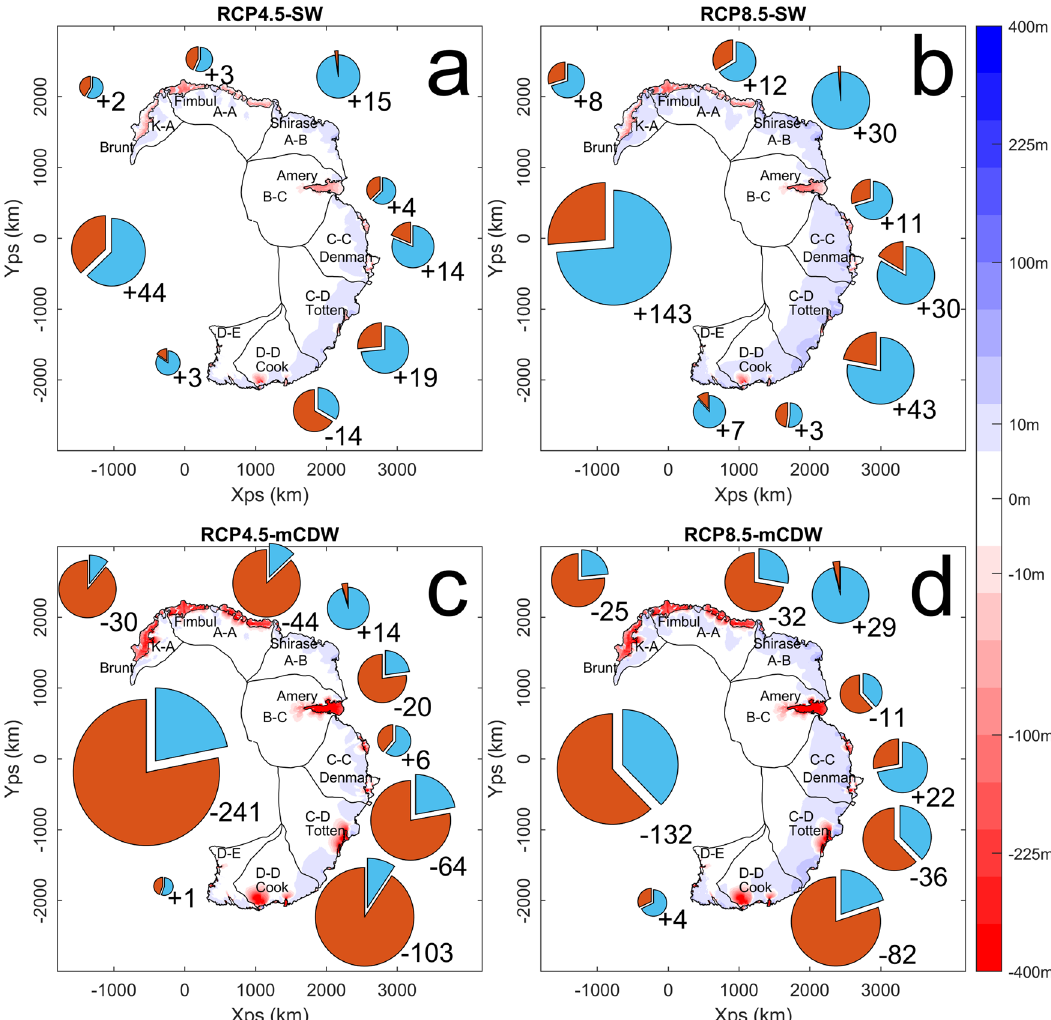
Fig. 4 | Regional mass balance of the East Antarctic Ice Sheet after 200 years. Total mass balance in GTa − 1 for the eight model catchments as well as the total model domain (pie charts, with area proportional to the net mass balance and the relative contribution of ice discharge in red and surface precipitation in blue) and